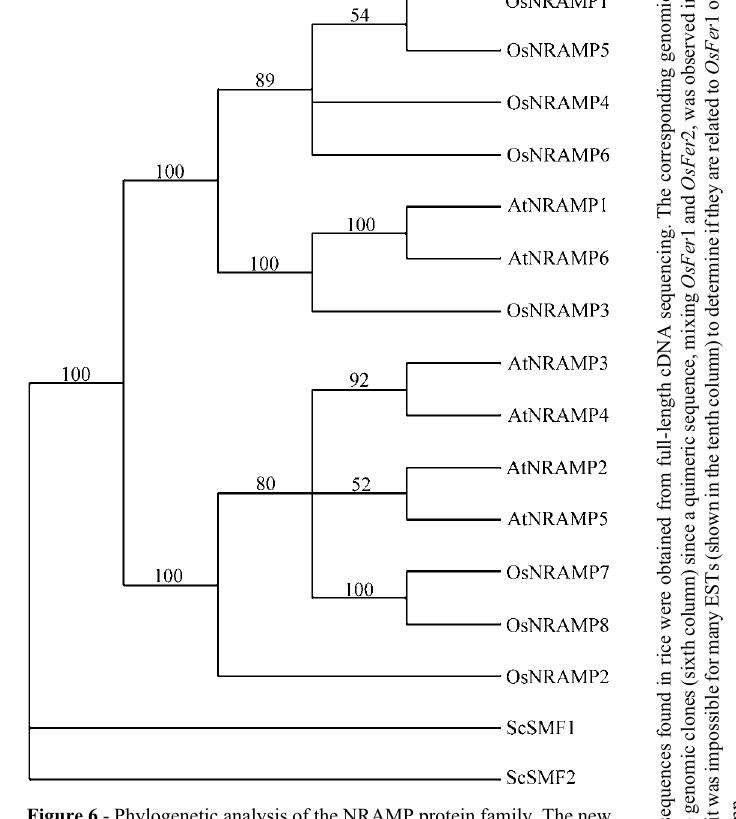
Figure 6 - Phylogenetic analysis of the NRAMP protein family. The new OsNRAMP proteins were analyzed together with the NRAMP proteins from Arabidopsis and the S. cerevisiae SMF1 and SMF2 polypeptides. Accession numbers of nucleotide sequences and corresponding predicted OsNRAMP proteins are shown in Table 4. Accession numbers to the other proteins are: AtNRAMP1: AAF36535; AtNRAMP2: AAD41078; AtNRAMP3: NP_179896; AtNRAMP4: AAF13279; AtNRAMP5: NP_193614; AtNRAMP6: NP_173048; ScSMF1: AAB48984; ScSMF2: